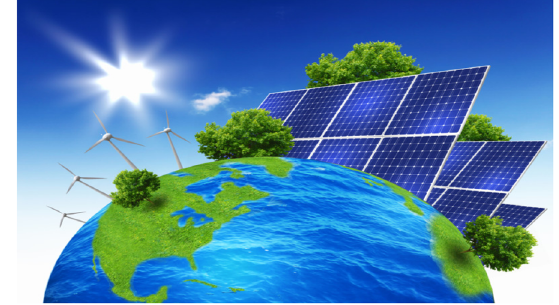
Fig. 3 Renewable Energy Sources